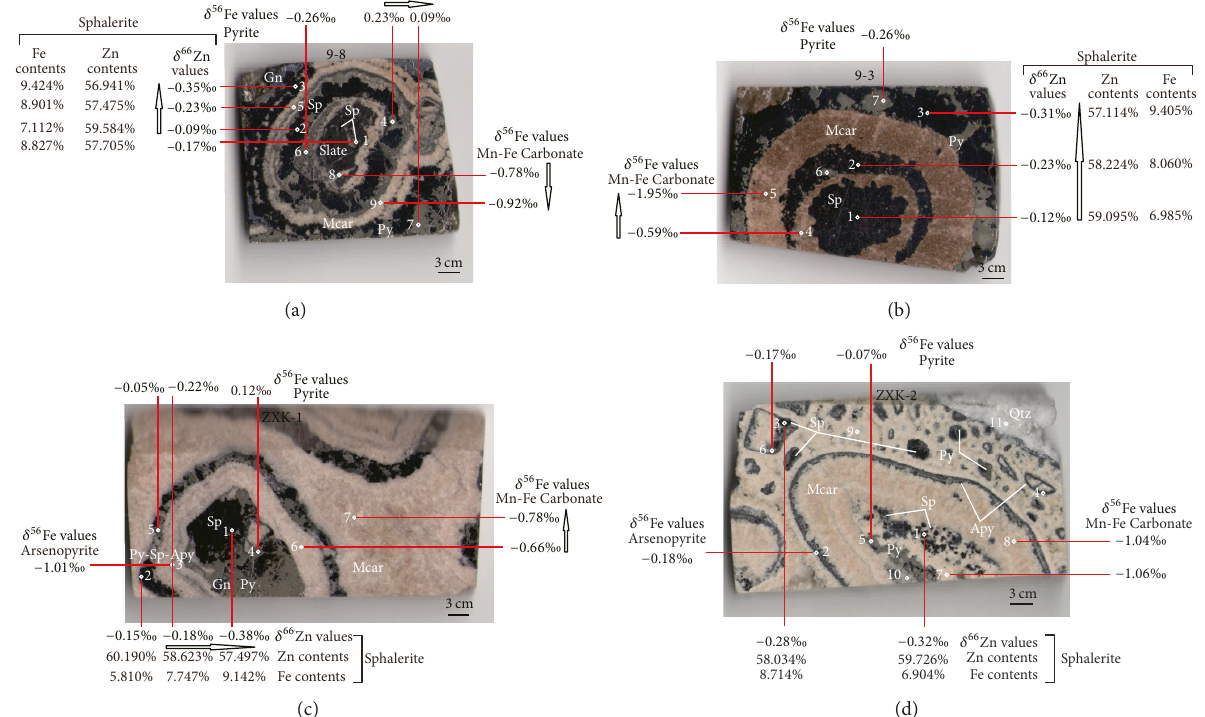
Figure 5: The sampling points and Fe-Zn isotopic-elemental variations in the annular polished section samples: (a) 9-8; (b) 9-3; (c) ZXK-1; (d) ZXK-2. Mcar = Mn-Fe carbonate; Apy = arsenopyrite; Py = pyrite; Sp = sphalerite; Qtz =